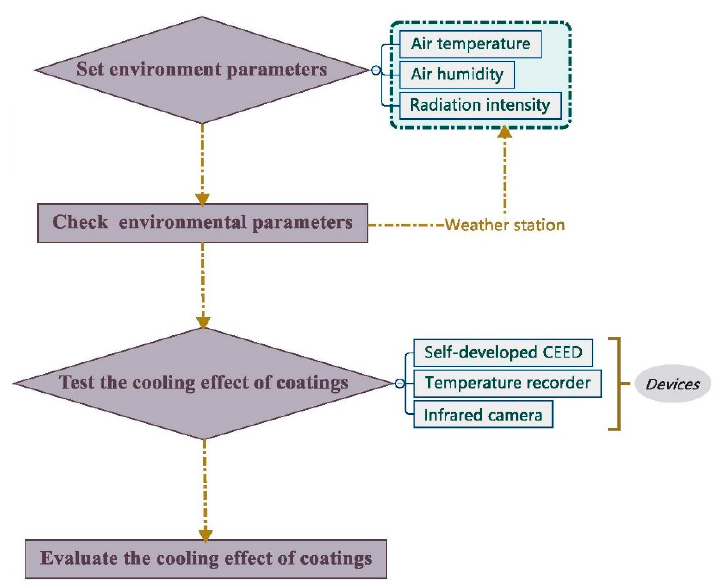
Figure 5. Specific steps of the cooling effect test.